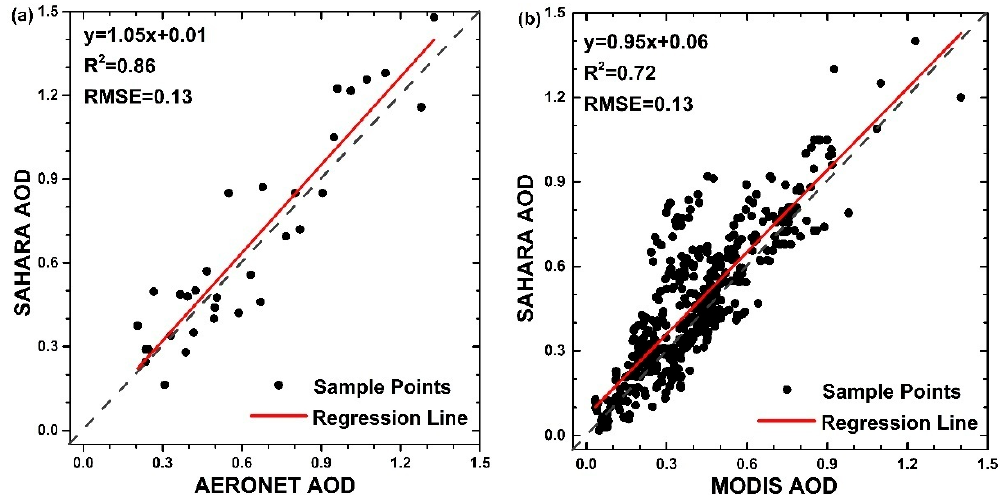
Figure 12. Scatter plots of SAHARA AOD and AERONET AOD ( a ) and MODIS AOD ( b ), the dashed (black) and solid (red) lines are 1:1 line and the regression line, respectively.